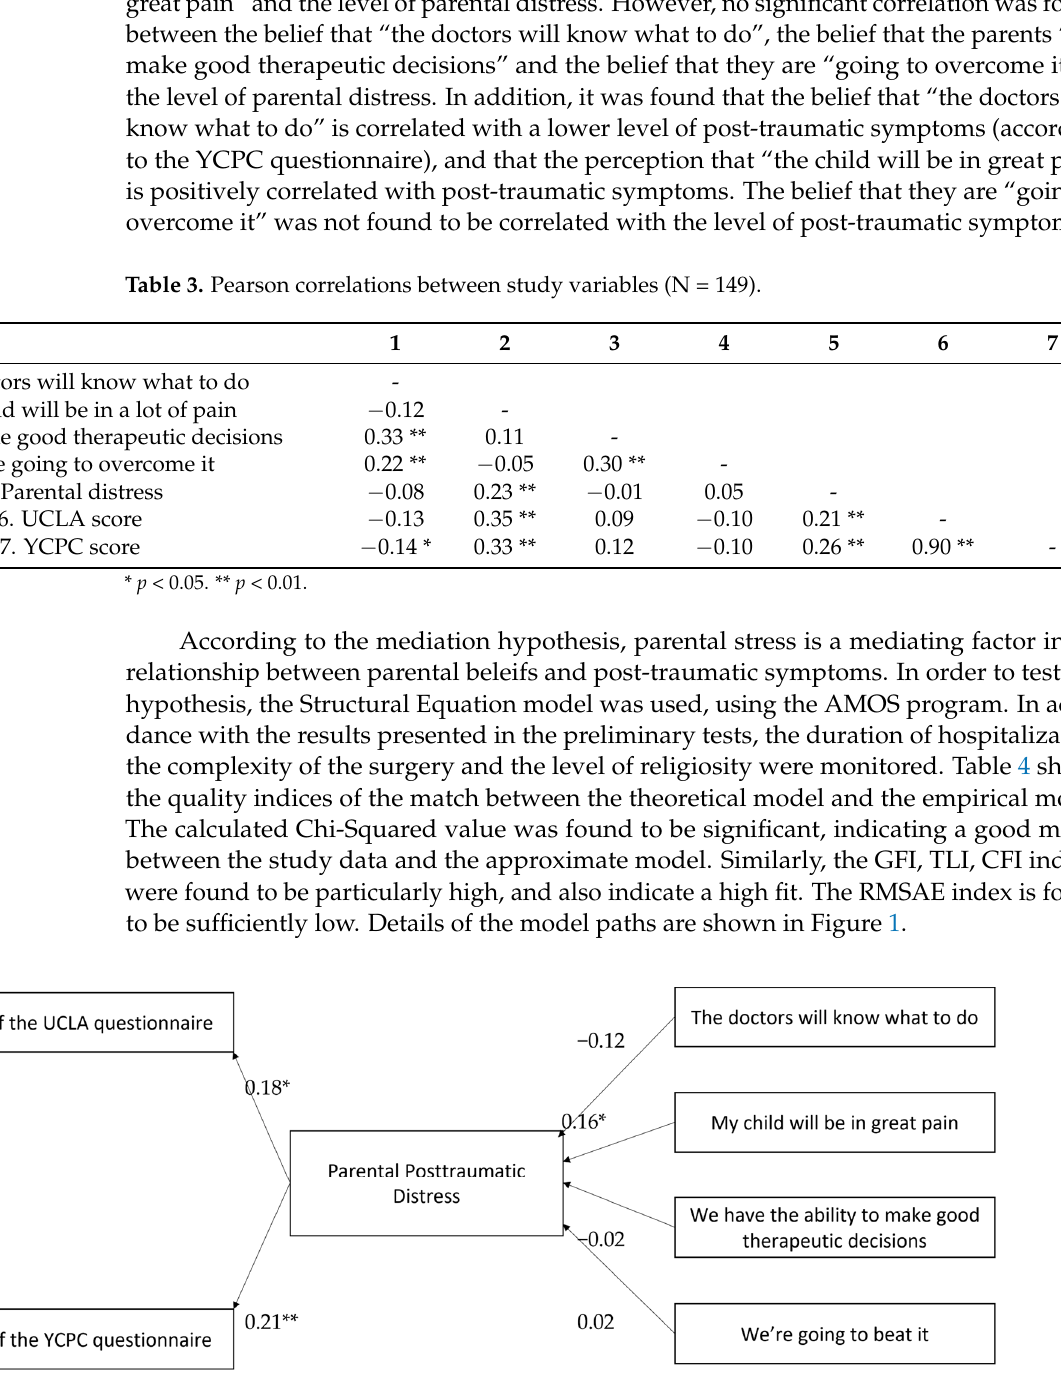
Figure 1. Summary of the mediation model the relationship between parental beleifs and post-traumatic symptoms by parental distress. (*) = Statistically significant relationship with confidence level of >0.5. (**) Statistically significant relationship with confidence level of